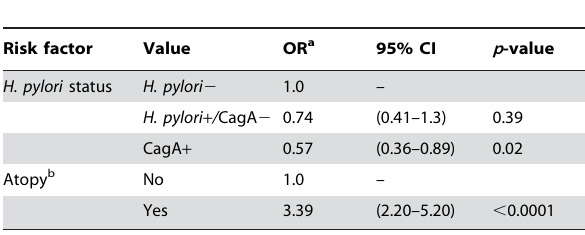
Table 3. Association between H. pylori status or atopy and asthma using generalized estimating equation (GEE) multiple logistic regression analysis (N=